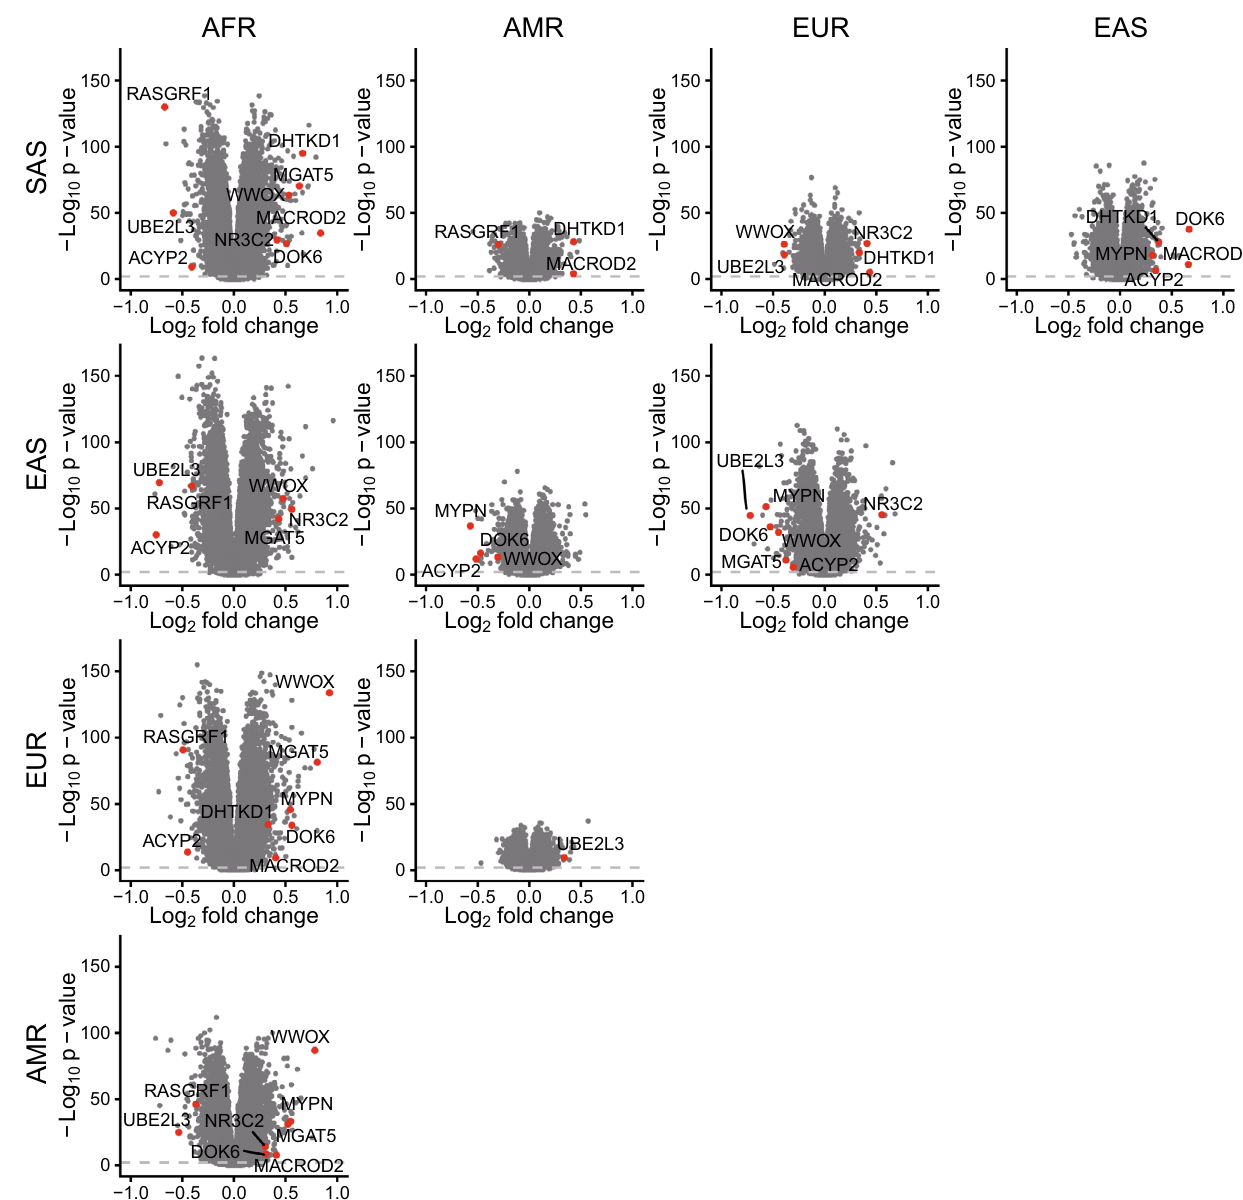
Fig. 6 | Comparing STR lengths across the fi ve superpopulations in the 1KGP dataset. PairwisecomparisonsofaveragepSTRlengthsbetweensuperpopulations from the 1KGP are shown using volcano plots. pSTRs with top length differences were labeled using the genes in which they reside. The sample size of each